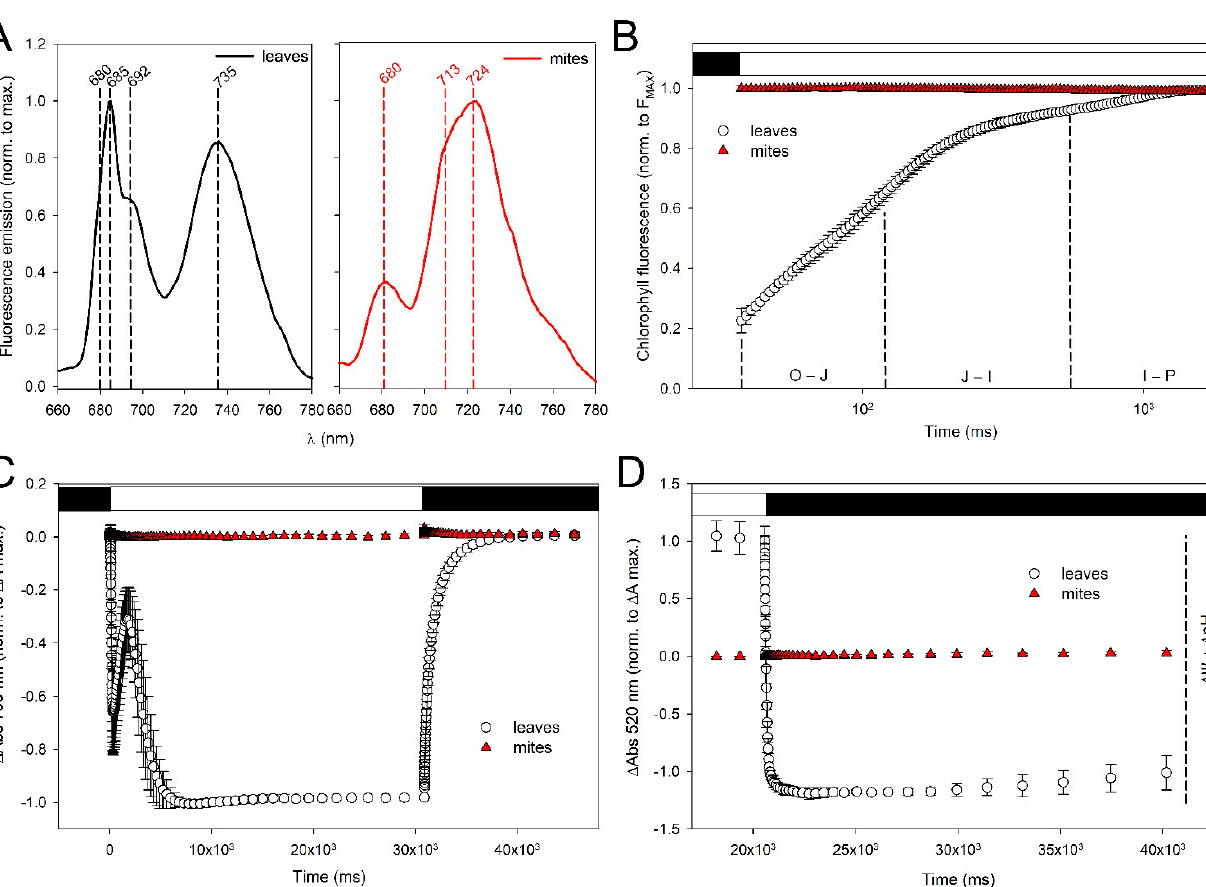
Figure 10. Photosynthetic activity in Lima bean leaves and in the TSSM. ( A ) 77K fluorescence emission spectra were recorded on chloroplasts from Lima bean leaves and on TSSMs. λ exc = 440 nm, λ emiss = 660–780 nm. Each spectrum was normalized to the maximum emission. Data are expressed as mean values of three fluorescence curves. ( B ) PSII fluorescence induction kinetics (0JIP transient). Fluorescence rise was induced on dark-adapted leaves and TSSMs, using a saturating flash of green light (1100 µmol photons m − 2 s − 1 for 1 s). Traces have been normalized to the F MAX value. ( C ) P700 oxidation kinetics. Absorbance changes at 705 nm were measured in Lima bean leaves and TSSMs and normalized to the maximum Δ Abs measured in leaves. The samples were illuminated with far-red actinic light (730 nm, 1500 µmol photons m − 2 s − 1 for 15 s) followed by 15 s of dark relaxation. ( D ) Kinetics of the ECS signal normalized to the maximum Δ Abs measured in leaves at the end of the light window. The samples were illuminated with actinic light (640 nm, 940 µmol photons m − 2 s − 1 for 120 s) followed by 20 sec of dark relaxation. The transient changes of the ECS, upon switching the light off, reflect the different rates of relaxation of the two components of the transmembrane protonmotive force ΔΨ and Δ pH. In panels ( B – D ), symbols and error bars show means ± SD n = 4, and black and white bars represent dark and light phases, respectively.